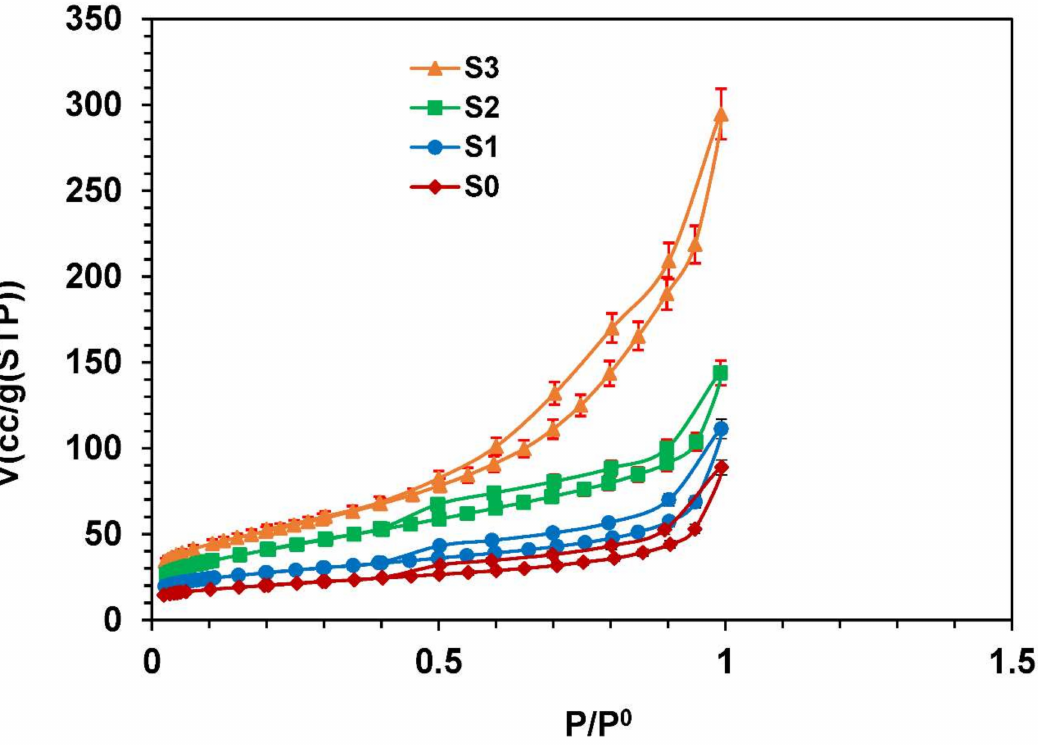
Figure 9. N 2 adsorption isotherms of the raw material ( S 0 ) and activated clay samples ( S 1 , S 2 , S 3 ) with ± 5% error bars in volume.